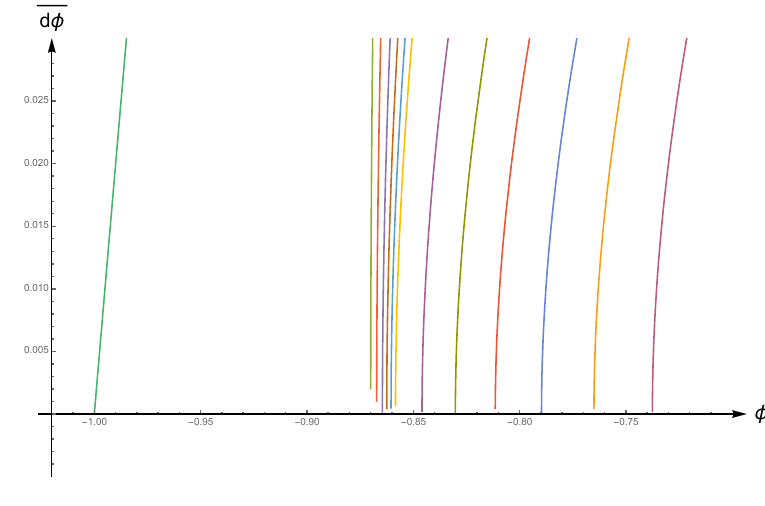
Figure 31 . A closer look at the near-bounce region of (cid:12)gure 30. The leftmost curve corresponds to the zero temperature solution and the remaining curves are superpotentials at (cid:12)nite temperature. The derivative of each (cid:12)nite-temperature superpotential vanishes at a di(cid:11)erent bouncing point, where the each solution is glued to the next branch. The closer to (cid:0) 1 the zero of dW=d(cid:30) is, closer the horizon is to (cid:30) = 1 and lower is the black-hole temperature. No (cid:12)nite-temperature solution reaches (cid:30) = (cid:0) 1, thus showing that the minimum-to-minimum zero temperature (cid:13)ow from [12] does not have an associated black-hole solution with a running scalar.